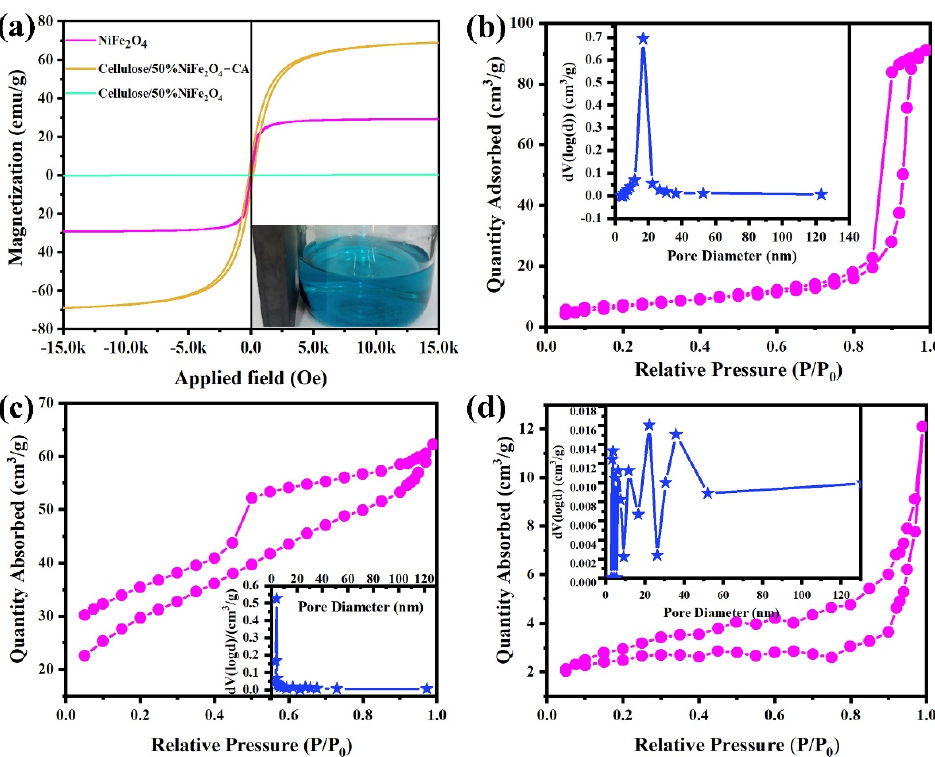
Figure 3. ( a ) Hysteresis loops of NiFe 2 O 4 , cellulose/50%NiFe 2 O 4 − CA − 600 °C, cellulose/50%NiFe 2 O 4 hybrid aerogels; N 2 isothermal adsorption/desorption and pore diameter distribution curves of ( b ) NiFe 2 O 4 , ( c ) cellulose/50%NiFe 2 O 4 − CA − 600 °C, ( d ) cellulose/50%NiFe 2 O 4 hybrid aerogels.